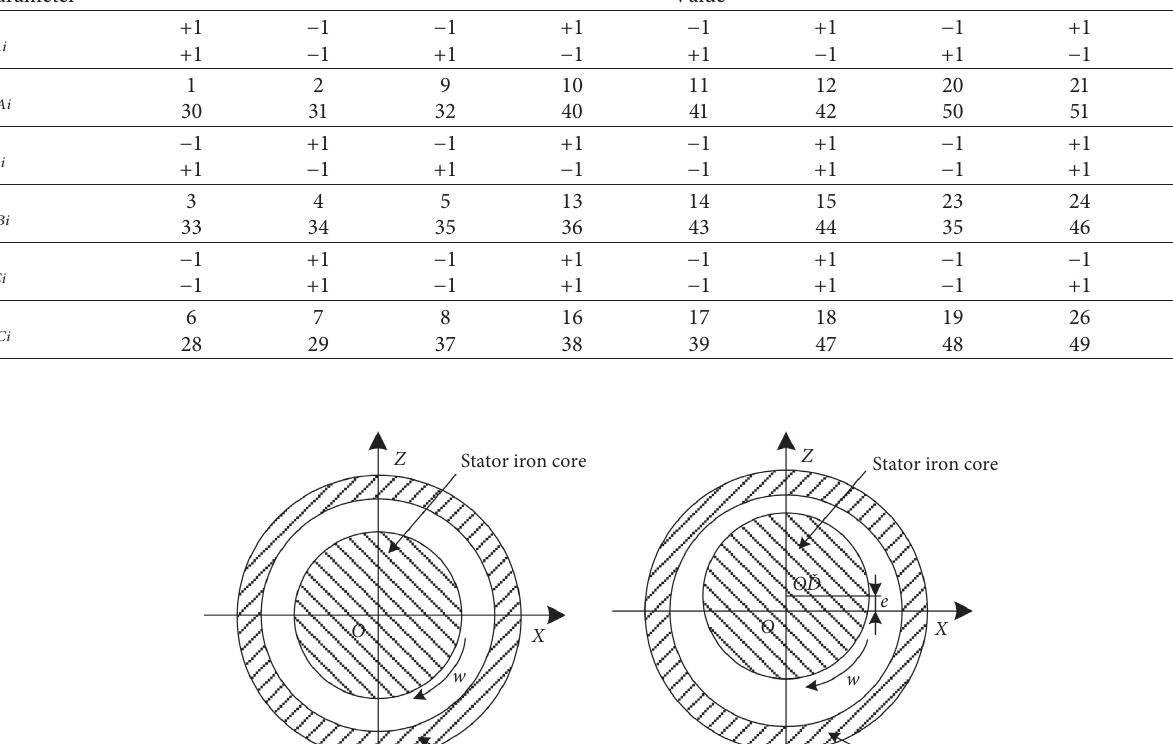
Figure 3: Magnetic potential vector of the three-phase armature winding. Table 1: Vectors of the three-phase magnetic-potential vector direction and the angles of the magnetic potential vector. Parameter